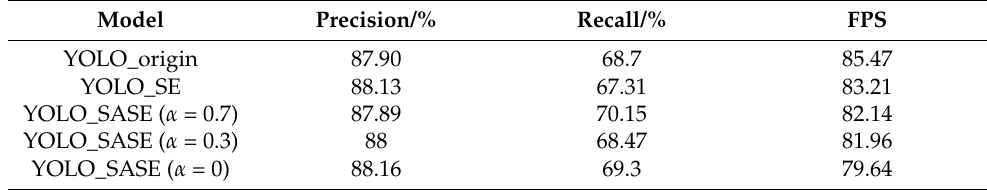
Table 3. Comparison experiment of P/R effect of SASE module, training epochs were